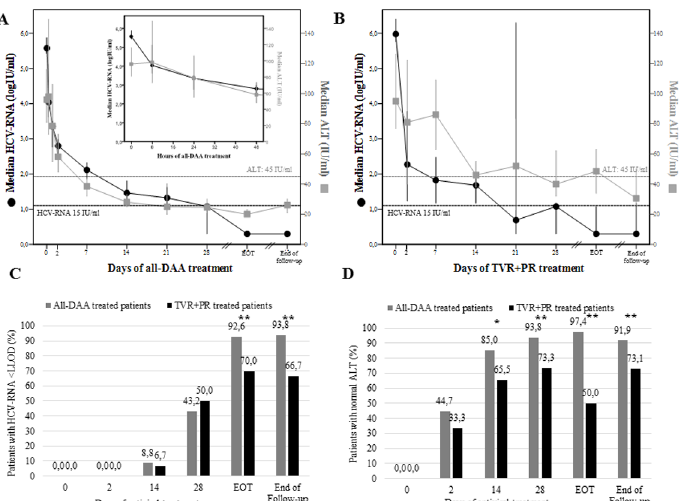
Fig 1. Biphasic kinetics of HCV-RNAdecay, and ALT drop during all-DAA and TVR+PR treatment and follow-up. In upper panels ,median values with 95% confidenceinterval of HCV-RNA (black dots) and ALT (grey squares)duringall-DAAs (panel A ) and TVR+PR (panel B ) treatment are reported.End of follow-upis at 12 weeks after treatment discontinuation. Black dotted line representsthe lower limit of detectionof HCV-RNA (12–15IU/ml). Grey dotted line represents normality range of ALT values in females (45 IU/ml). Histograms in lower panels represent the percentagesof patients with HCV-RNA belowthe lower limit of detection(panel C ) and with normal ALT values (panel D ) during all-DAAs (black) and TVR+PR (grey) treatment. Normal ALT values were considered as < 55 IU/ml in men, and < 45 IU/ml in women. ALT, alaninetransaminase; DAA, direct-acting antivirals; EOT, end of treatment; IU, international units; LLOD, lower limit of detection( < 12–15 IU/ml, not detected); PR, pegylatedinterferonand ribavirin;TVR, telaprevir. * p-value < 0.05 by Fisher exact test; ** p-value (cid:20) 0.001 by Fisher exact